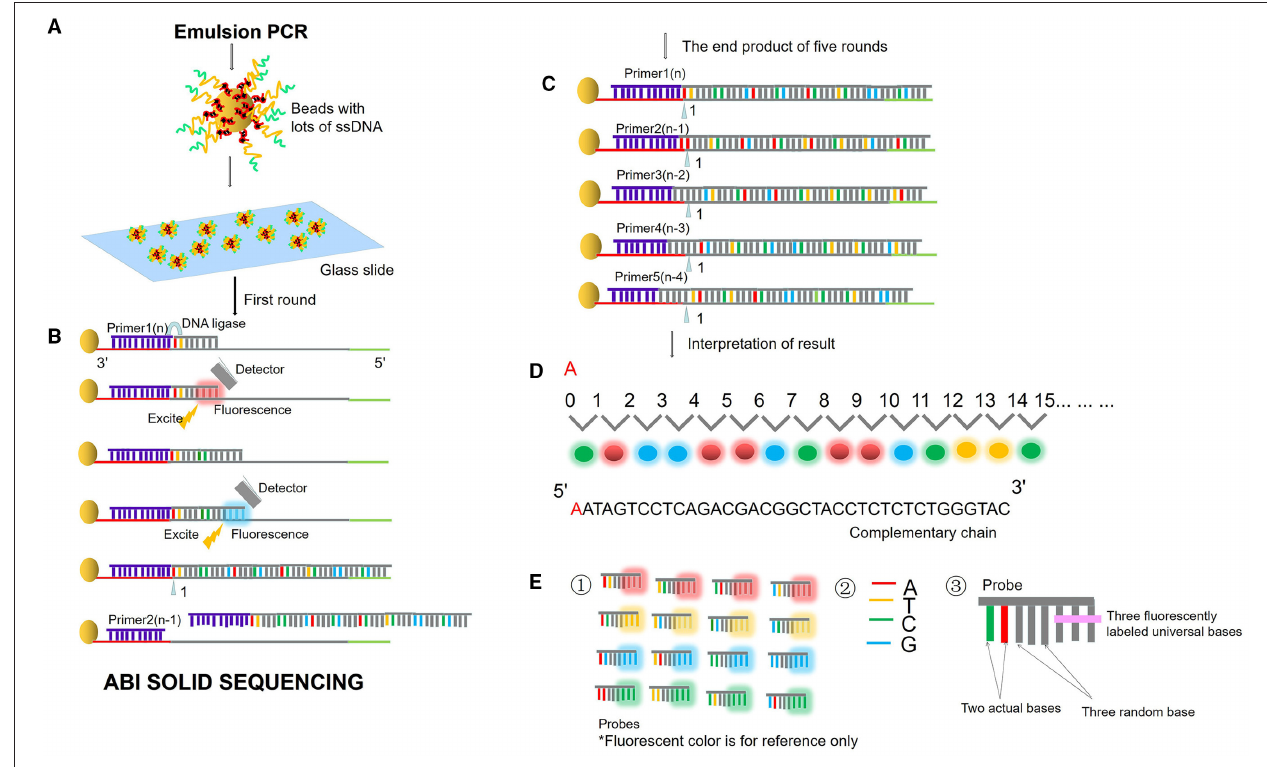
FIGURE 4 | ABI sequencing by oligonucleotide ligation and detection (SOLiD). (A) Emulsion PCR. After the emulsion is amplified, a large number of amplified products from the DNA template are attached to the magnetic beads. Then, the magnetic beads are deposited on the glass slide. (B) SLB. The first circle of sequencing reaction includes: the sequencing primer is combined with the template; the probe is combined with the template; the ligase connects the sequencing primer and the probe, excites the probe fluorescence, and removes the last three bases of the probe. Then plus the second probe, connects the two probes with the ligase, excites the probe fluorescence, and removes the last three bases of the probe. Repeat the above reaction to synthesize the whole chain. (C) Solid template shift. After cutting off the whole synthetic ligation, add sequencing primer n-1, repeat the above steps and start the second circle of reaction. Unidirectional solid sequencing requires five circles of sequencing reactions. The primers are n, n-1, n-2, n-3, and n-4, respectively, and the bases at each position are detected two times. (D) Fluorescent signal reception and interpretation of results. (E) Two-base encoding principle. ‹ “two-base encoding” specifies the corresponding relationship between different base pairs and four probe colors in the coding region (e.g., red fluorescence represents AT, TC, CA, GT). › Four bases. fi The probe is an 8-base single-chain fluorescent probe. The base pairs at positions first and second of the probe are determined, positions from third to fifth are random bases, which can be any of the four bases of “A, T, C, and G,” and positions from sixth to eighth mark four fluorescent dyes of different